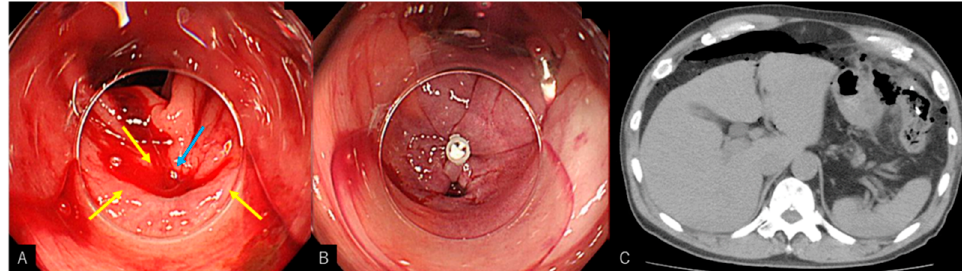
Figure 5. A case of delayed perforation occurred after HSE-C (hypertonic saline epinephrine injec- tion with clipping) at the splenic flexure. ( A ) 1.5 mL HSE was injected at 3 points (yellow arrow), adding up to 4.5 mL, and a single clip was placed indirectly at the neck of the diverticulum (blue arrow). ( B ) Hemostasis was confirmed, and further clipping was not possible due to the instability of the scope. ( C ) CT scans revealed free air in the abdomen on day 5 and subsequent emergency surgery was